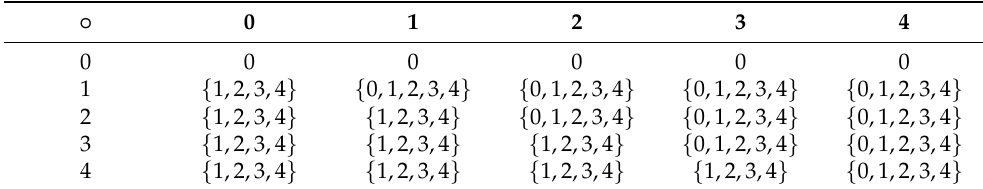
Table 19. Generalized quasi-left alter quasi-hyper BZ